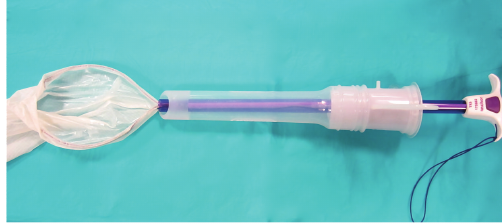
Figure 7: Apparatus assembled for specimen